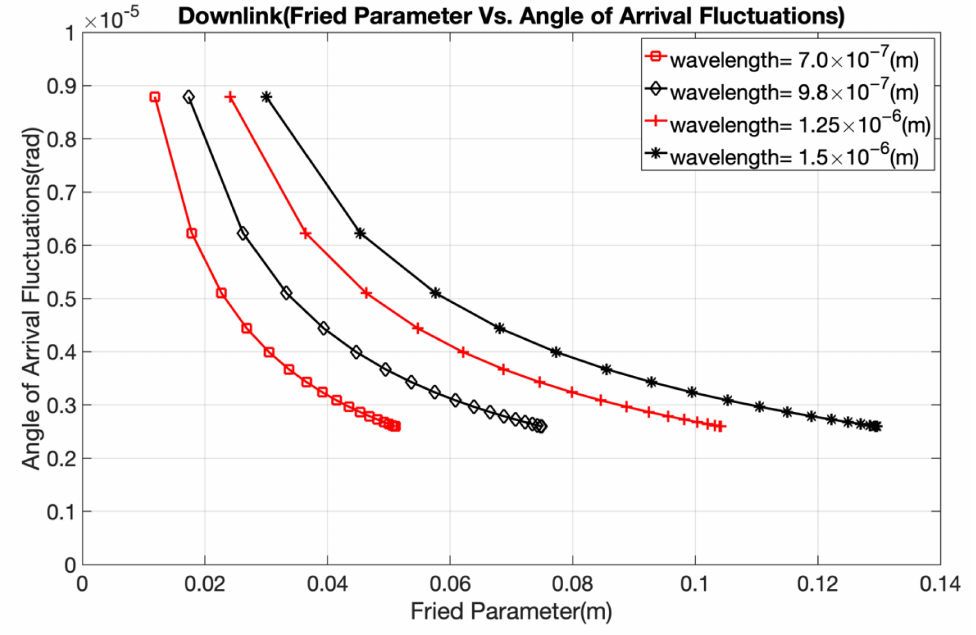
Figure 11. Variation in angle-of-arrival fluctuations (diameter = 5